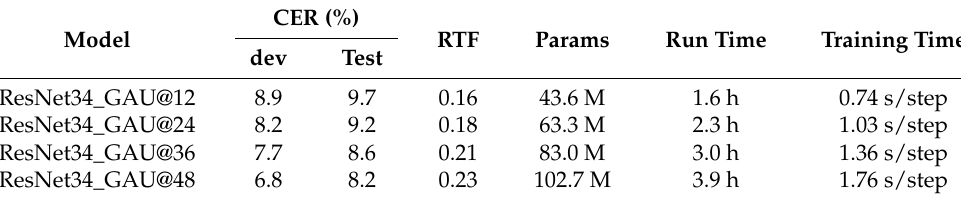
Table 4. Evaluation metrics of GAU module with different layers in the ATC